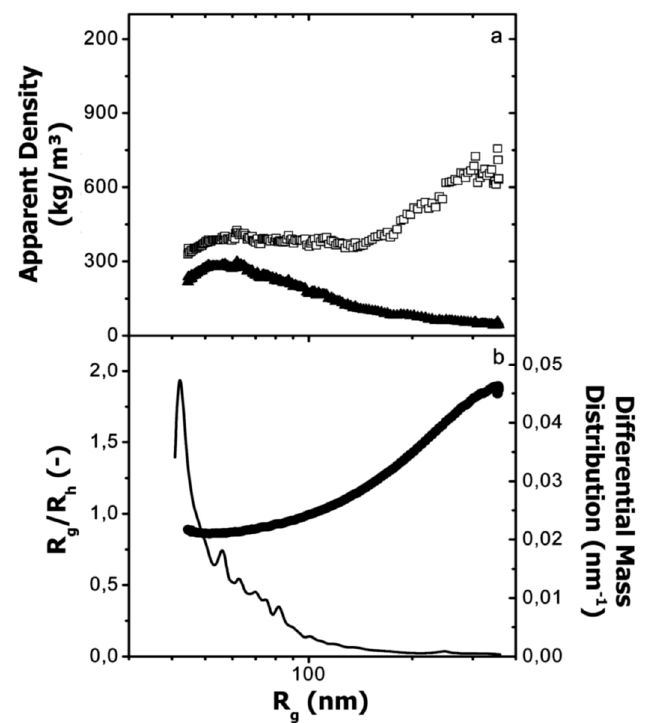
Figure 17. ( a ) Apparent density calculated from the radius of gyration ( R g ; ▲ ) and the hydrodynamic radius ( R h ; □ ) vs. R g , and ( b ) R g / R h ( ● ) and di ff erential mass distribution (-) vs. R g for casein micelles in milk. Reproduced with permission from [184]. Copyright by American Chemical Society, 2010.